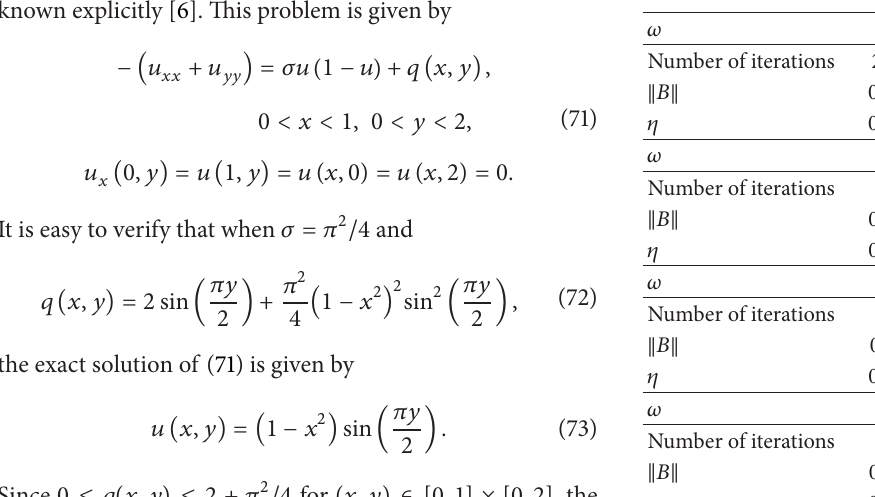
Table 2: Numbers of iterations and 𝜂 values for Example 20.